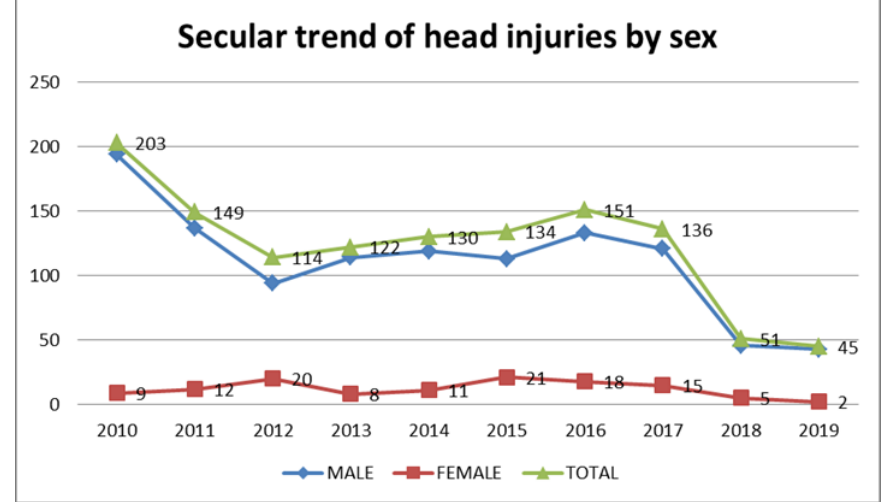
Figure 1. Secular trend of traumatic head injuries in Aseer, Saudi Arabia. Table 2. Pattern of head injuries and its outcomes by gender ( n =